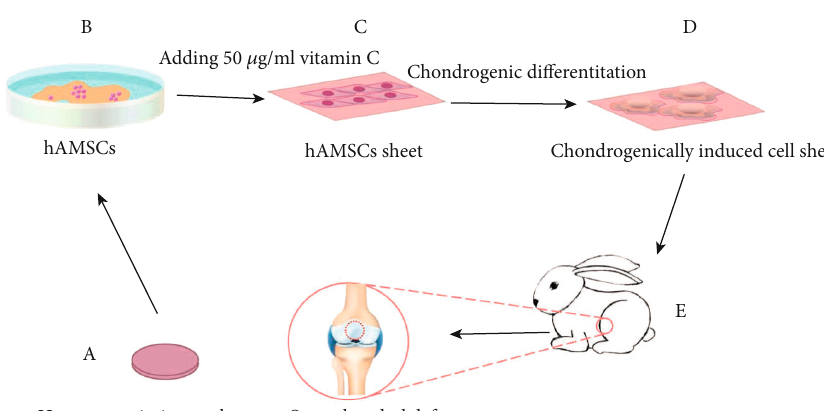
Figure 1: The schematic diagram of the experimental operation. (a) Harvesting human amniotic membrane from placentas. (b) Isolating hAMSCs from the human amniotic membrane of placentas by twice digestion with trypsin and once digestion with collagenase type II. (c) Fabricating hAMSC sheet by adding 50 μ g/ml vitamin C into cell sheet induction medium. (d) Fabricating chondrogenically induced hAMSC sheet by changing for cell sheet induction medium for chondrogenic induction medium. (e) Creating rabbit osteochondral defects in the center of the femoral trochlear groove and the osteochondral defects were treated with nothing, noninduced cell sheet and chondrogenically induced cell sheet. hAMSCs: human amniotic mesenchymal stem